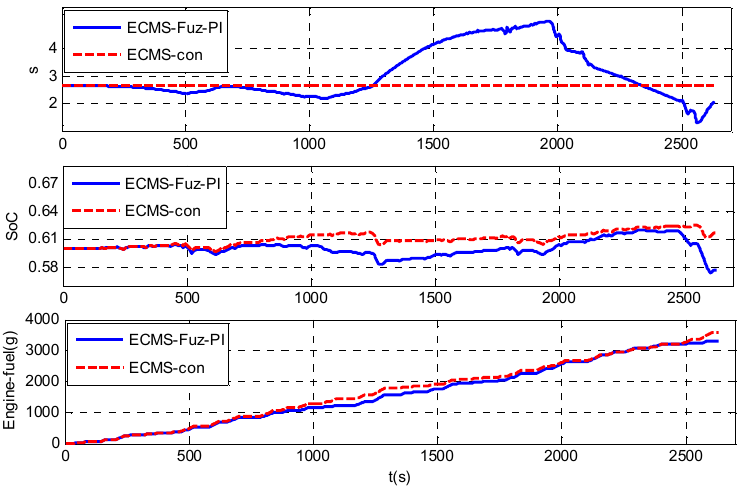
Figure 17. Comparison of performances using two kinds of EF (2 × CHA).